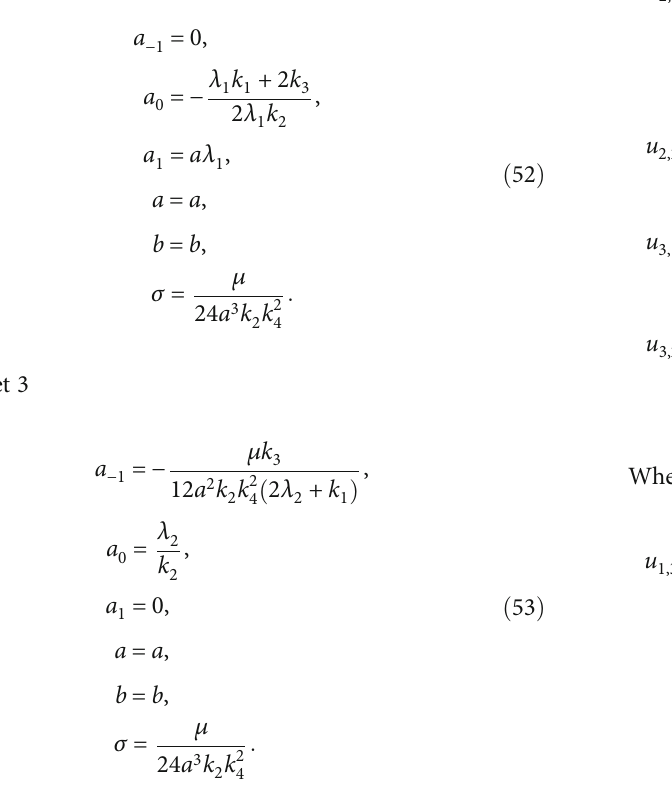
ffiffiffiffiffiffiffiffiffi μ